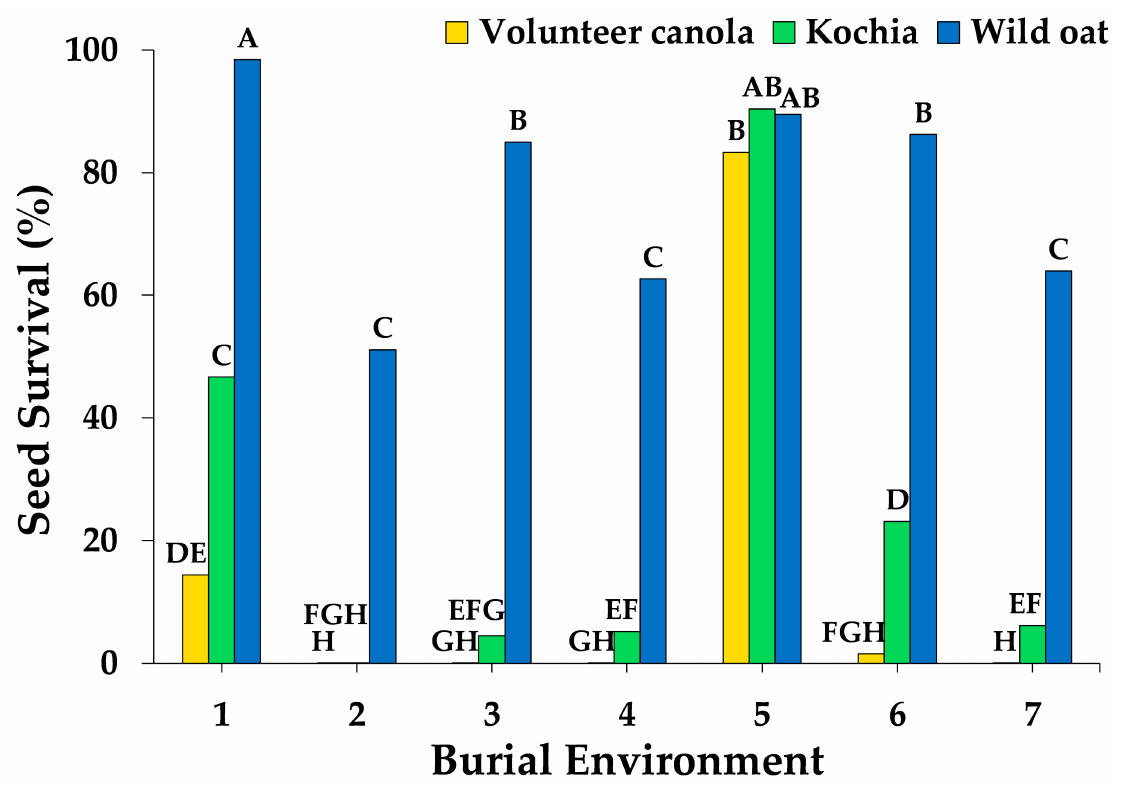
Figure 2. The percentage of volunteer canola, kochia, and wild oat seeds that survived a 7 week burial period in seven different environments planted to wheat, canola, and field pea (n = 9). Bars indicate back transformed arcsine square root means among crop species. Different letters indicate significant difference based on Tukey’s HSD ( α = 0.05).